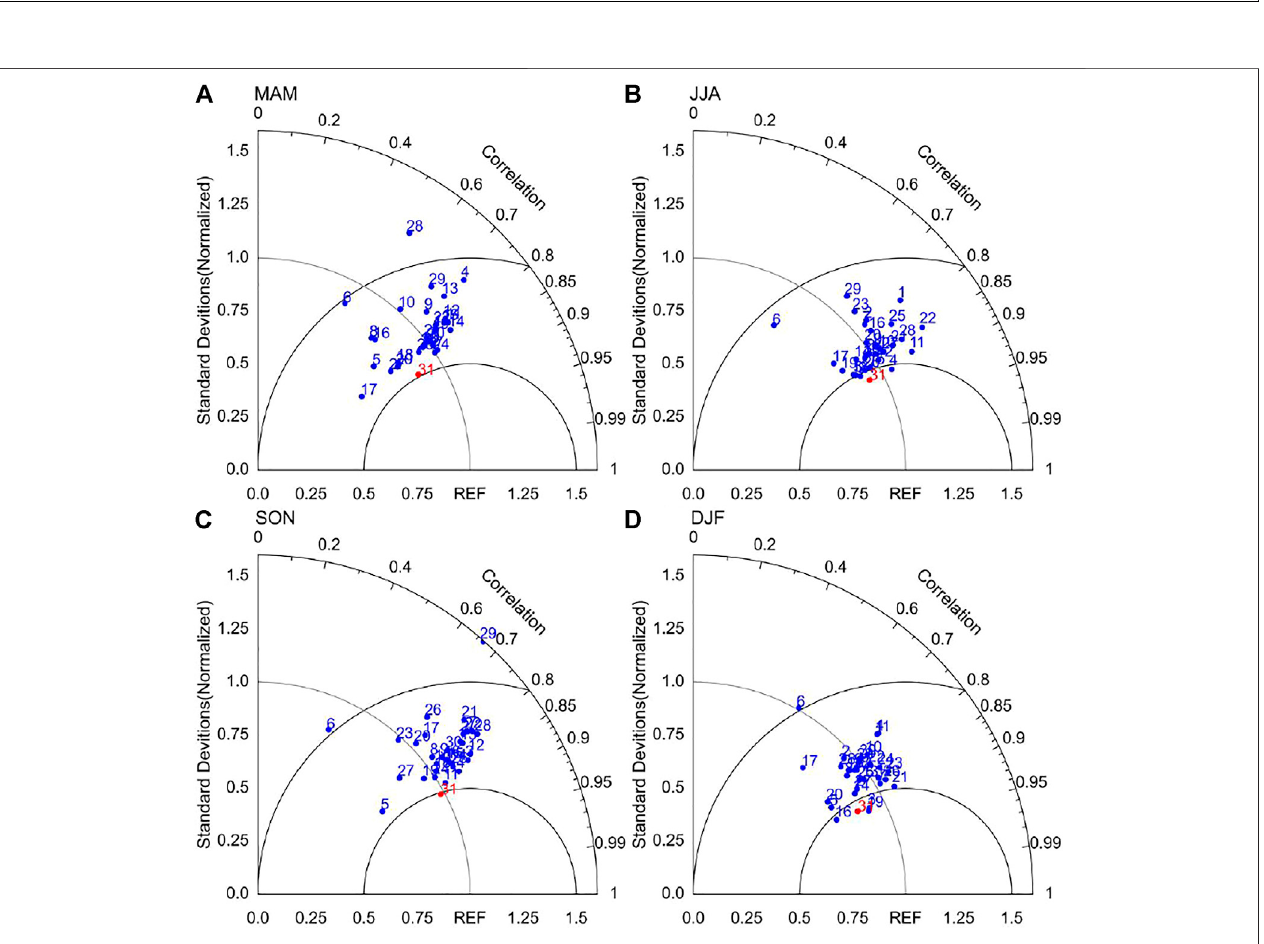
FIGURE 5 | Same as in Figure 1 , but for (A) spring, (B) summer, (C) autumn and (D) winter UTT standard deviation during 1965 – 2014.